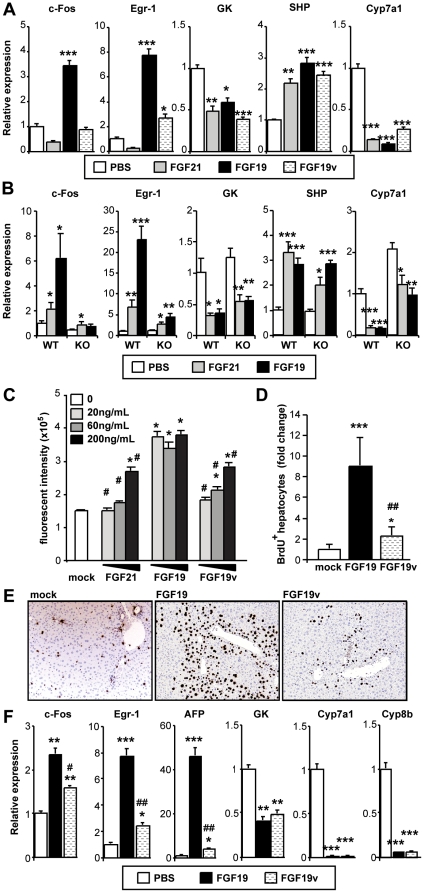
Biological activities of FGF19v in chow-fed lean mice.(A) An acute gene expression study. Overnight fasted FVB mice (N = 5–6) were injected via tail vein with indicated FGF protein at 1 mg/kg or PBS control. At 4 hours post-injection, hepatic mRNA was prepared from each mouse and subjected to real-time qPCR analysis for the indicated genes. p values: *<0.05, **<0.01, ***<0.001 (vs PBS) (B) A similar acute gene expression study. Overnight fasted WT or FGFR4 KO mice (N = 5–7) were i.p. injected with indicated FGF protein at 1 mg/kg or PBS control. At 4 hours post-injection, hepatic mRNA was prepared from each mouse and subjected to real-time qPCR analysis for the indicated genes. p values: *<0.05, **<0.01, ***<0.001 (vs PBS) (C) Anchorage independent cell growth assay. Proliferation of HepG2 cells in soft agar was estimated based on conversion of Resazurin (Alamer Blue), a non-fluorescent indicator dye, to resorufin. (D) Hepatic BrdU incorporation in FGF treated mice. FVB mice were implanted with an osmotic pump to continuously infuse indicated FGF protein at 1 ng/hr (∼0.8 mg/kg/day) (day 0). The mice also received daily injection of 1 mg/kg/day FGF protein (q.d.) and 30 mg/kg/day BrdU (b.i.d.) starting day 1. On day7, livers were dissected out and subjected to anti-BrdU staining. The results are shown as a fold induction over mock treated animals for the number of BrdU positive hepatocytes per area anlyzed. p values for (C) and (D): N = 6, *p<0.01, ***p<5E−5 (vs PBS), ##p<0.0002 (vs FGF19) (E) Representative images for (C). (F) Hepatic gene expression profile in mice used for (D) and (E). N = 6. *p<0.05, **p<0.005, ***p<0.001 (vs PBS), #p<0.05, ##p<0.005 (FGF19 vs FGF19v).